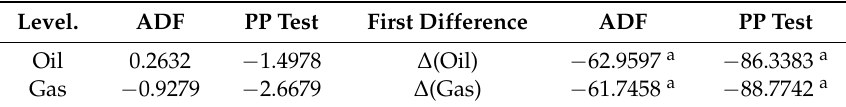
Table 1. Test for unit roots